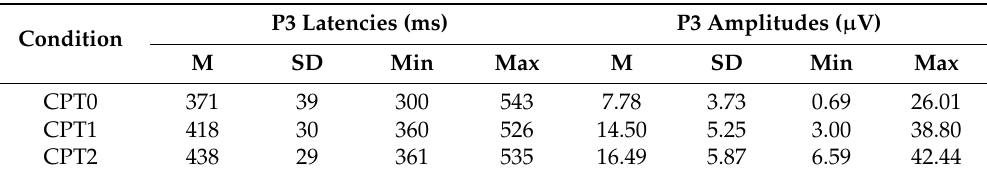
Figure 1. Grand average waves for the event-related potentials (ERPs) in the three CPT task conditions at the PZ electrode site. The zero point of the time scale refers to the onset. Negative is plotted upwards. Table 3. Descriptive statistics of P3 latencies and P3 amplitudes in the three CPT conditions in 110